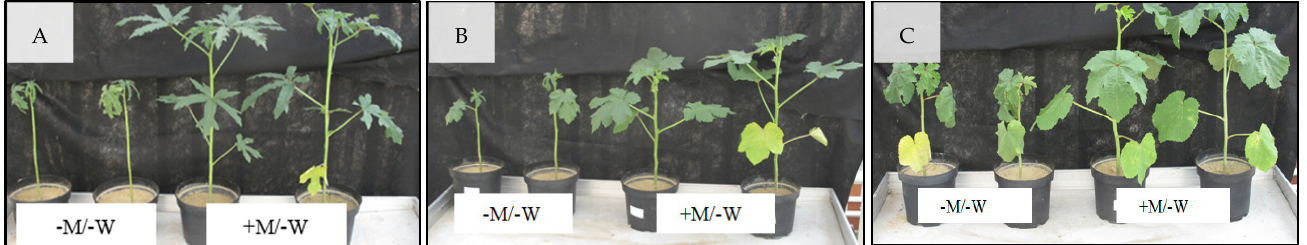
Figure A3. Mycorrhizal (+M) and non-mycorrhizal ( − M) okra plants grown under drought stress conditions ( − W). Shown are cultivars Khartoumia, HSD6719 and Clemson Spineless (( A – C ), respectively) on the day before harvest.